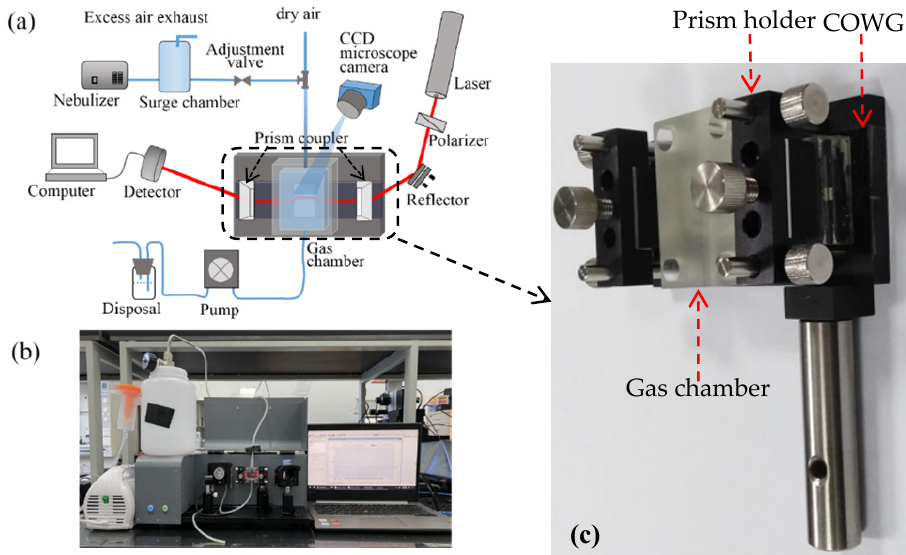
Figure 6. Experimental setup for aerosol deposition detection: ( a ) schematic diagram of the setup; ( b ) photograph of the setup; ( c ) photograph of the laboratory-made multipurpose holder contained in the setup.